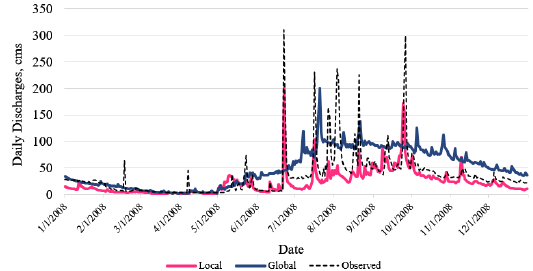
Figure 12. Discharge hydrographs after